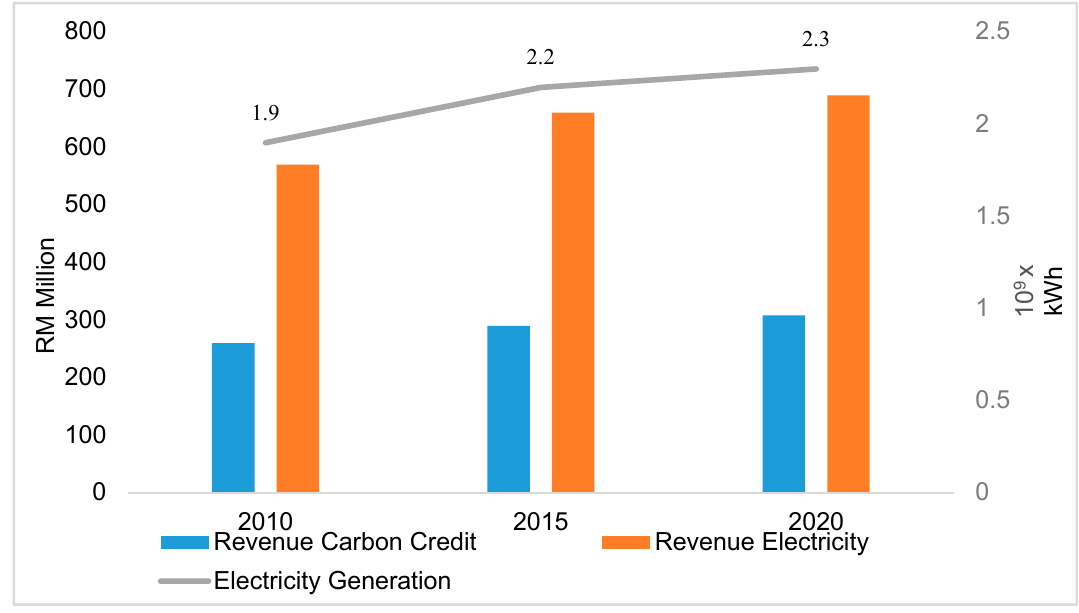
Figure 11. Electricity generation and revenue via landfill gas for the years 2010, 2015, and 2020 [33].